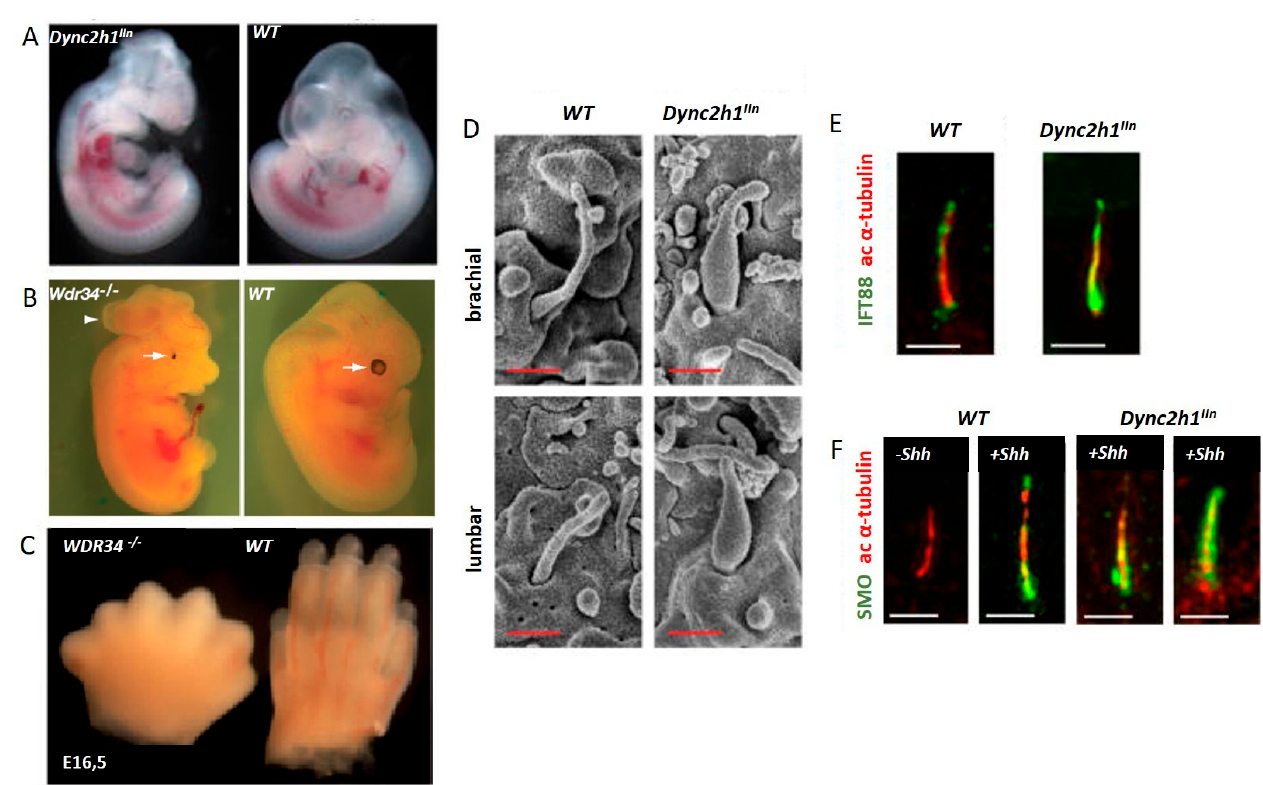
Figure 5. IFT dynein dysfunction results in a complex developmental phenotype in mice. ( A ) Dync2h1 loss of function mouse embryo showing a turning defect and CNS defects compared to a control embryo, reprinted with permission from Ocbina et al. Nat Genet 2011 Jun;43(6):547-53 [46]. ( B , C ) Wdr34 mutant mouse embryos compared to controls, reprinted with permission from Wu et al. Hum Mol Genet. 2017 Jul 1;26(13):2386–2397 [128]. White arrows in ( B ) indicate microphthalmia Wdr34 mutant embryo compared to control; the arrow head indicates encephalocele in the Wdr34 mutant ( D ) Shortened stumpy primary cilia in Dync2h1 mutant mice compared to controls, visualized using electron microscopy. ( E ) Accumulation of IFT 88 within the stumpy Dync2h1 mutant cilia compared to controls. ( F ) Ciliary accumulation of Smo in Dynch1 dysfunctional cells in the absence of Shh, as well as after Shh stimulation, compared with control cells, reprinted with permission from Ocbina et al. Nat Genet 2011 Jun;43(6):547-53 [46].